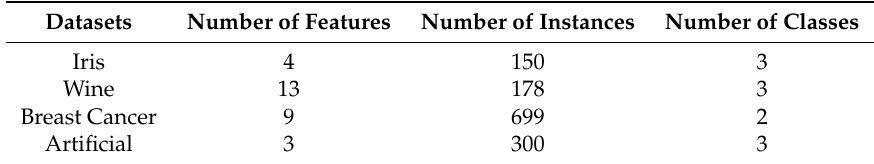
Table 2. Description of